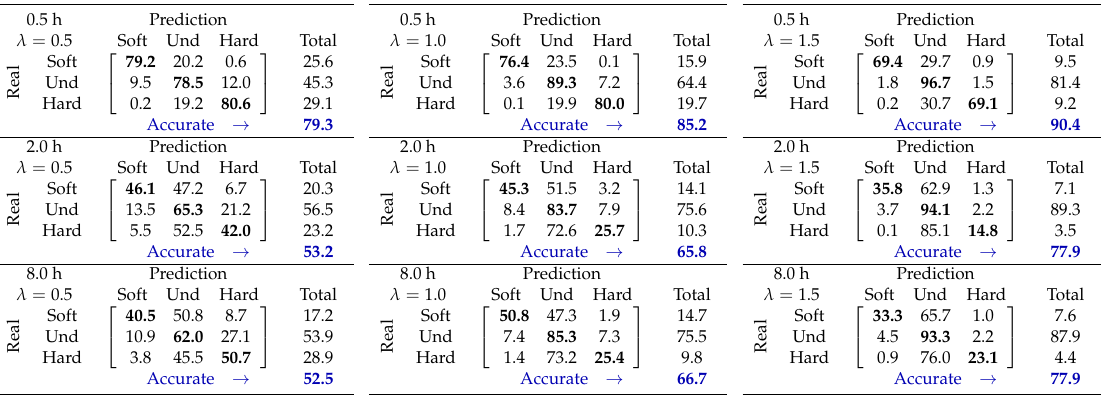
Table 7. SAG mill 2. Confusion matrices (percentage) of ORH prediction using λ : 0.5, 1.0 and 1.5 at 0.5, 2 and 8 h time